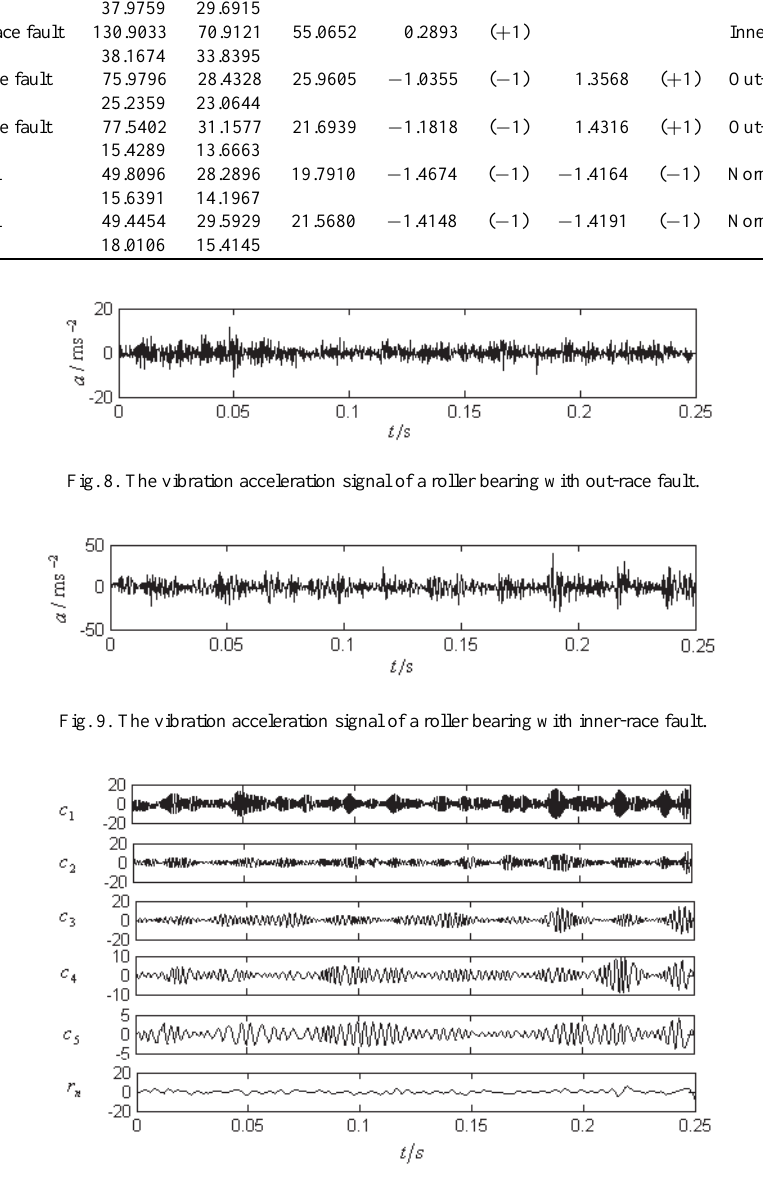
Fig. 10. The EMD decomposed results of vibration signal of the roller bearing with inner-race